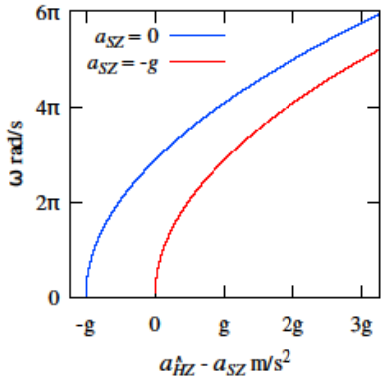
Figure 2. Possible backspin angular velocities as a function of the vertical fingertip acceleration relative to the shoulder for the shots with the vertical shoulder acceleration 𝑎 𝑆𝑍 = 0 with and 𝑎 𝑆𝑍 = −𝑔 .